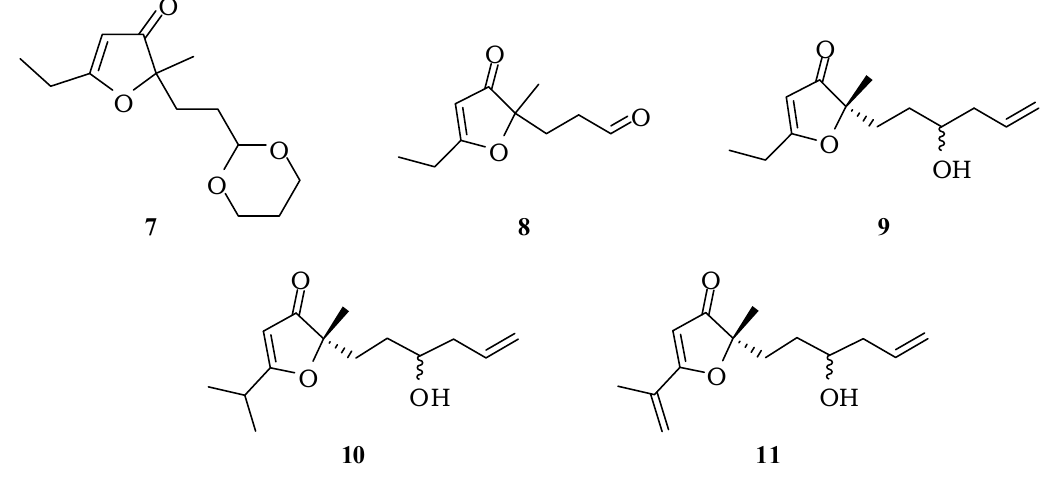
Figure 2. The series of 3(2 H )-furanones prepared in this